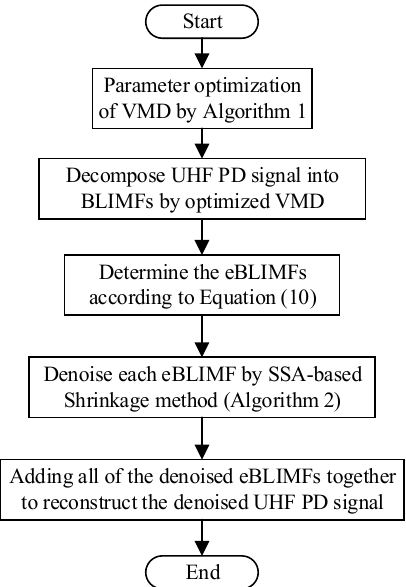
Figure 2. Schematic diagram of AVMDSSA denoising method.